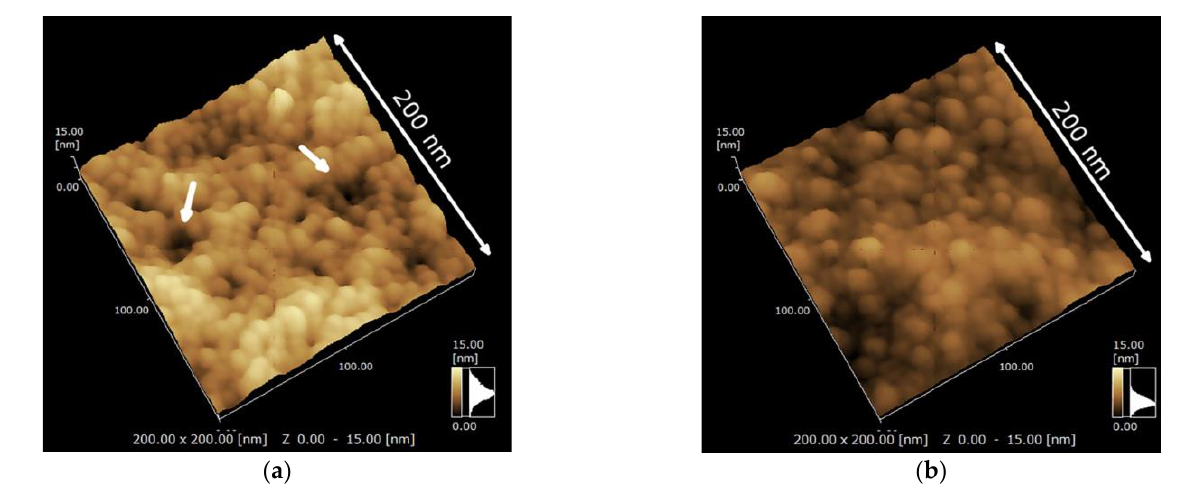
Figure 8. Scanning probe microscope (SPM) images of ( a ) current-anodized and ( b ) pulse-anodized NiTi surfaces. The white arrows show the pores on the surfaces of the coating. Adapted with permission from [174]. Copyright 2022, Elsevier.